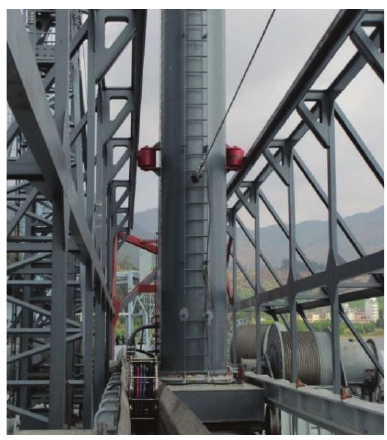
Figure 25: The underwater vehicle.